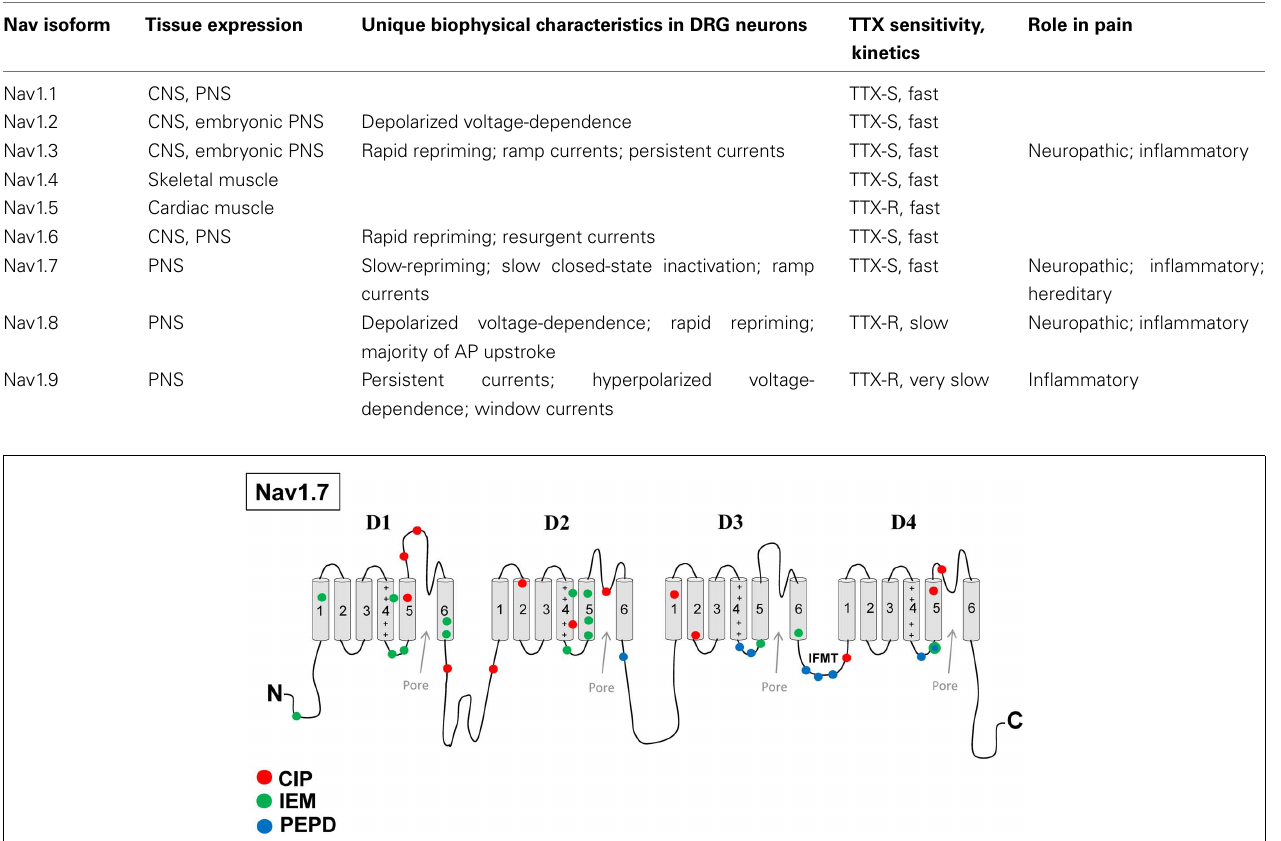
Table 1 | Summary of mammalian voltage-gated sodium channels.